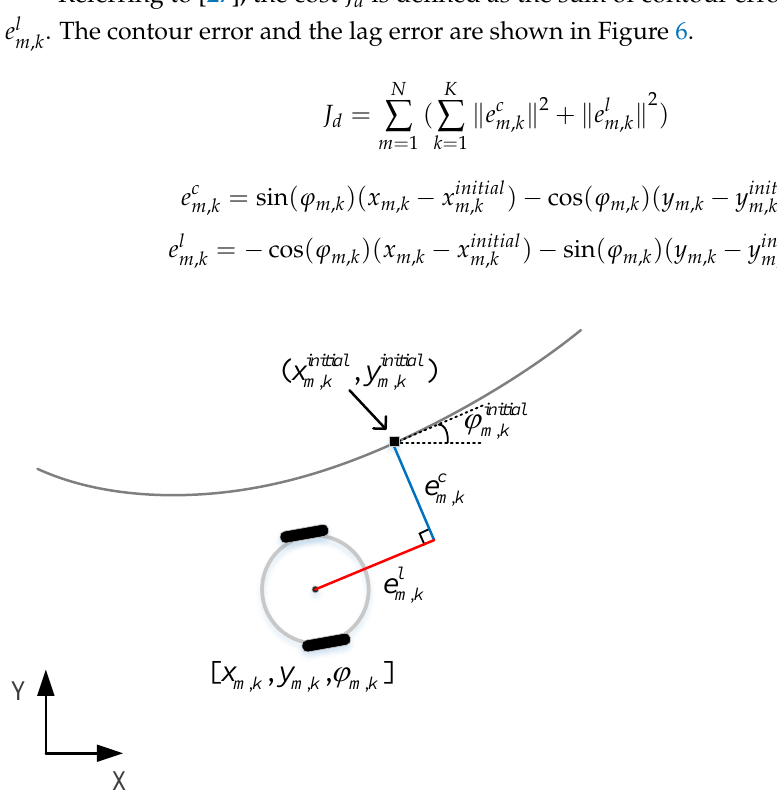
Figure 6. The contour error and the lag error The input smoothing term